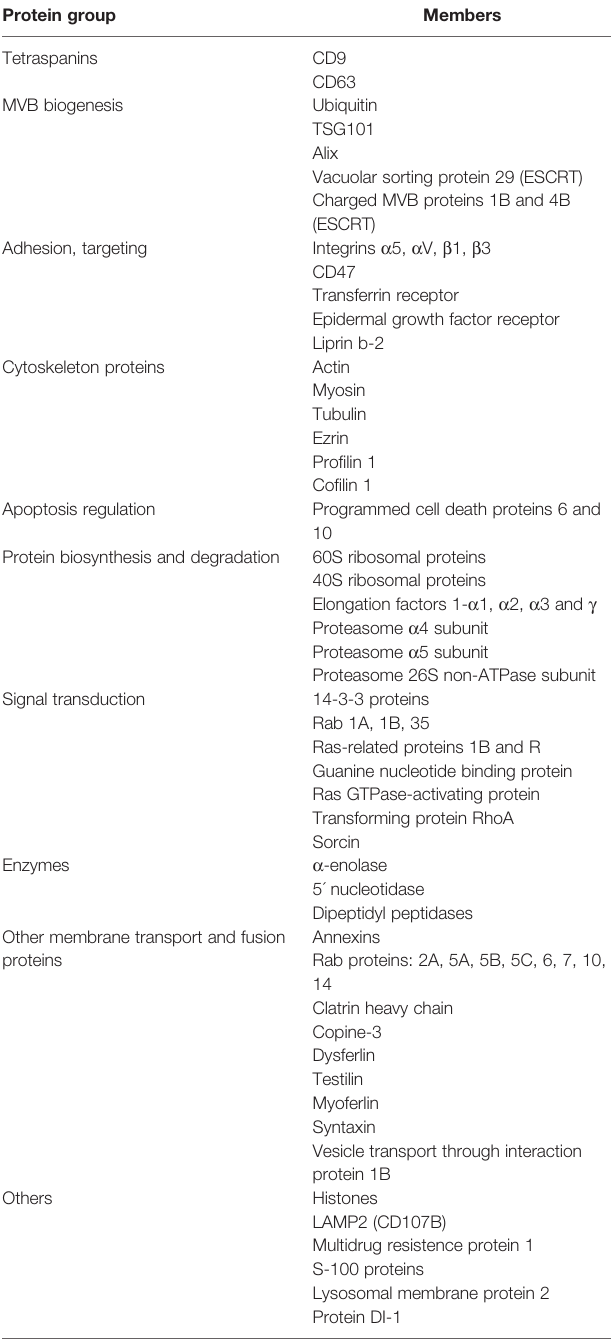
ESCRT, Endosomal-sorting complexes required for transport; MVB, Multivesicular